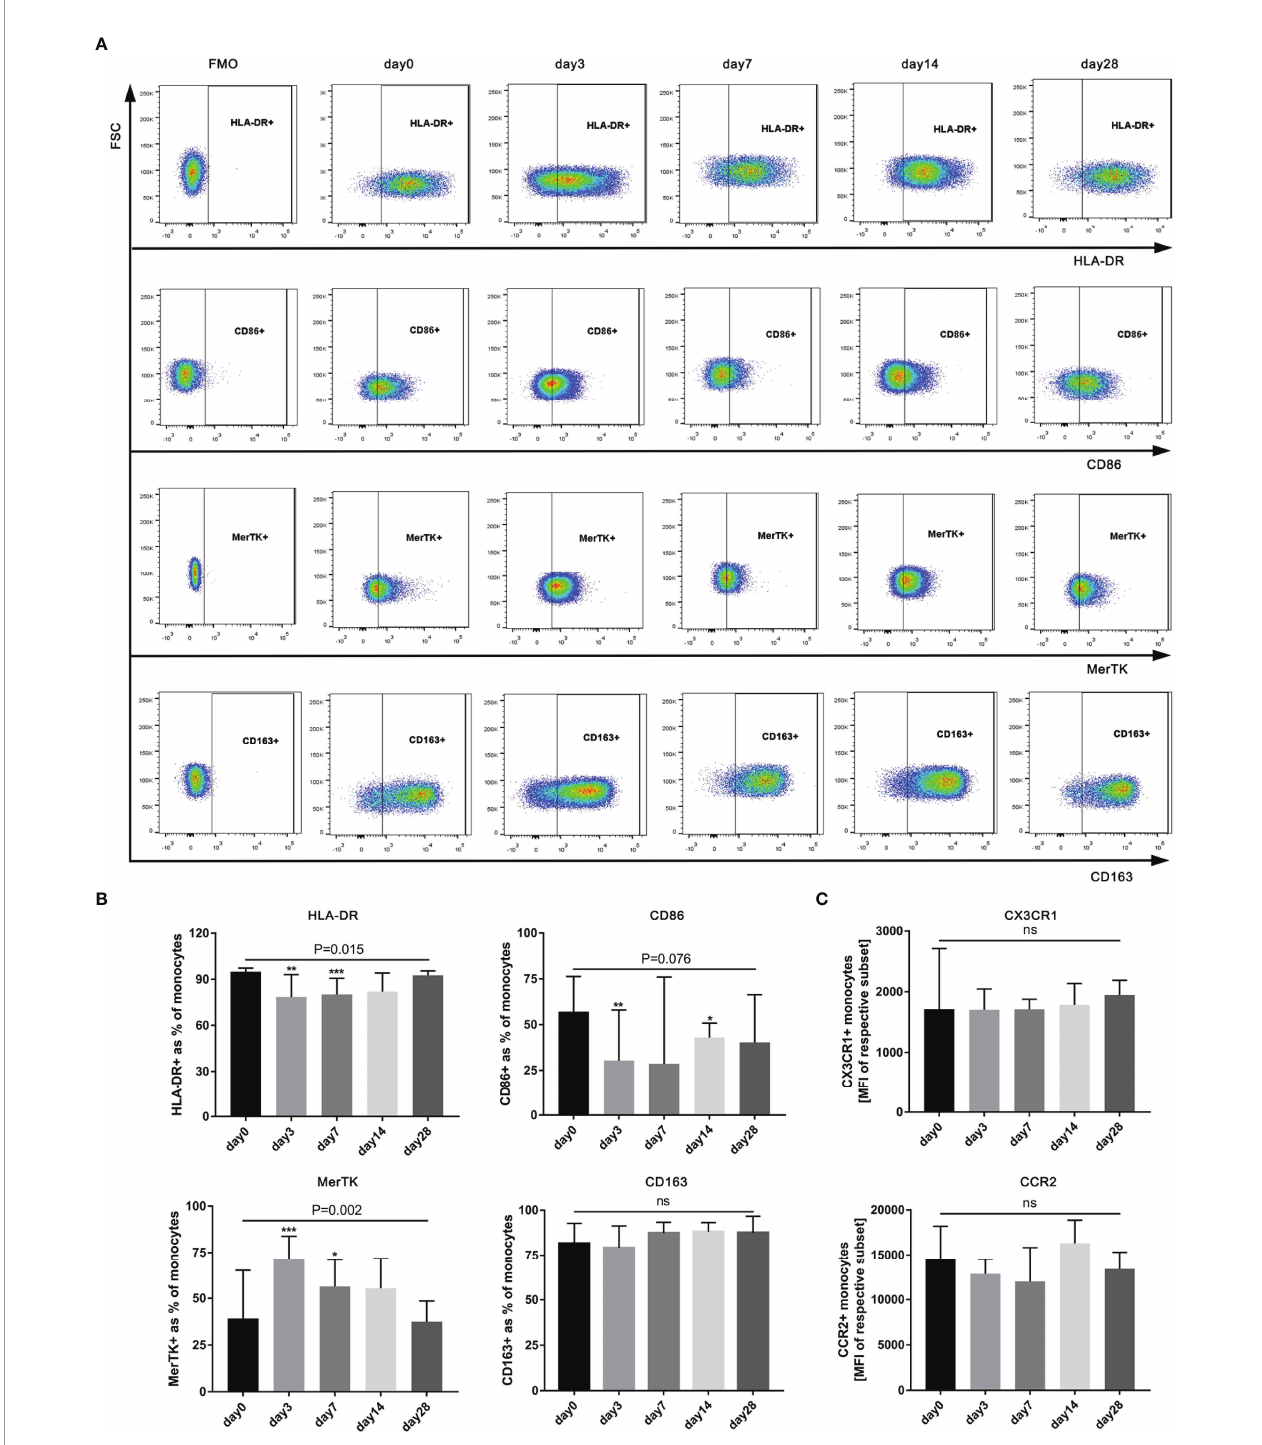
FIGURE 4 | Phenotype of circulating monocytes in HBV-ACLF patients (n=12) before (day 0) and after G-CSF treatment. (A) Expression of CD86 、 HLA-DR 、 MerTK, and CD163 on monocytes in HBV-ACLF before and after G-CSF treatment. (B) Phenotypic alterations on monocytes after treated with G-CSF. (C) Expression of tissue-homing receptors on monocytes after treated with G-CSF. Non-parametric (Wilcoxon ’ s matched-pair test) statistical analysis was used. Data presented as median with interquartile range. Compared with day 0, * P < 0.05, ** P < 0.01, *** P < 0.001. ns represents P > 0.05. G-CSF, Granulocyte-colony stimulating factor; HBV- ACLF, hepatitis B virus-related acute-on -chronic liver failure; FSC, forward